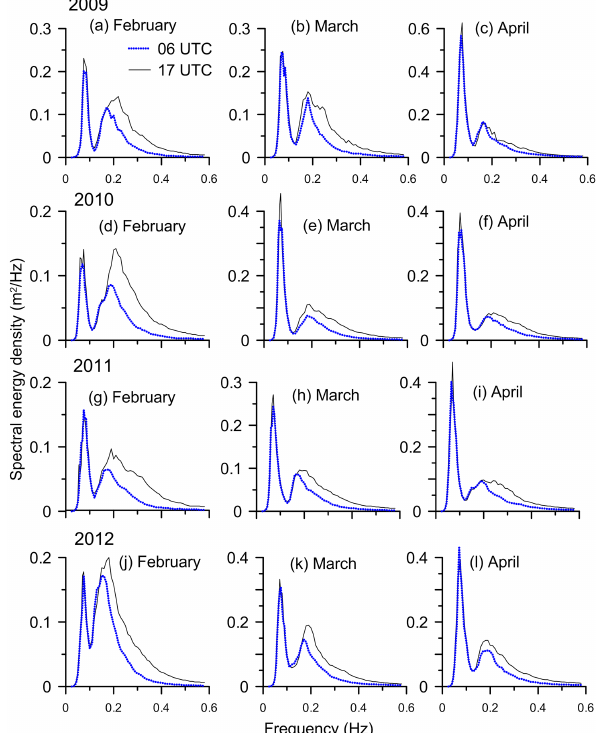
Figure 13. Monthly average wave spectrum during 06:00 and 17:00UTC from February to April in (a – c) 2009, (d – f) 2010, (g – i) 2011 and (j – l) 2012.